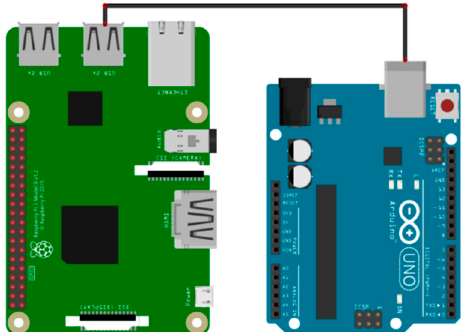
Figure 1. Raspberry Pi and Arduino connected in series from the USB.